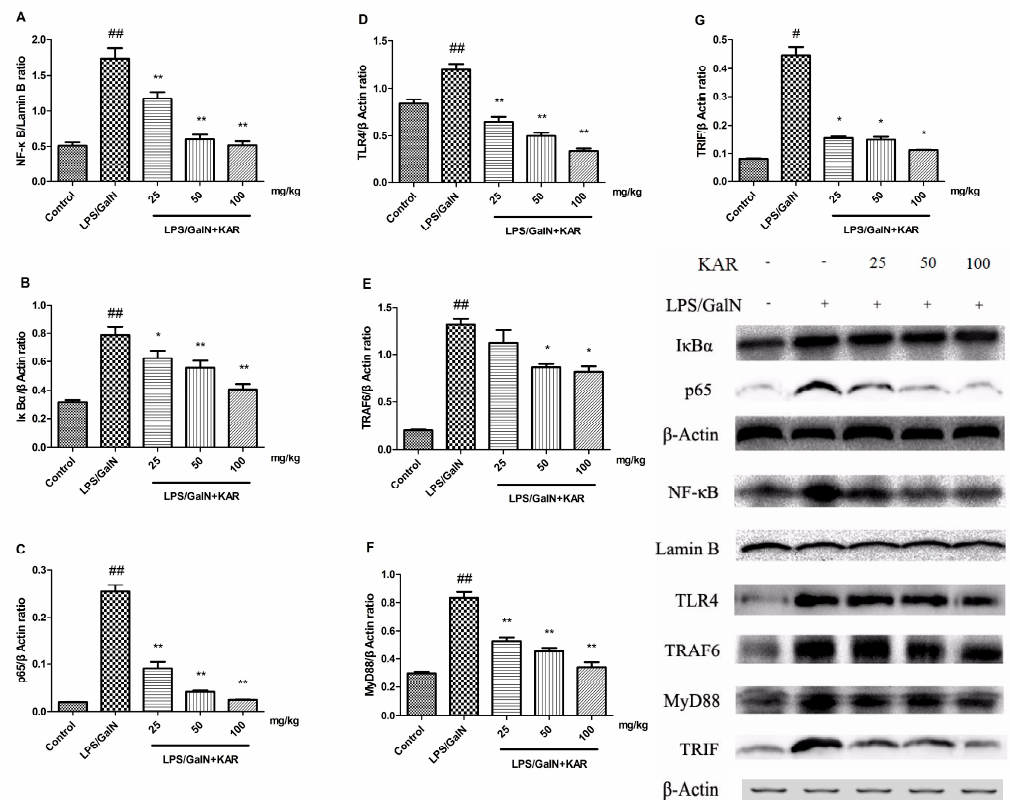
Figure 7. The expression of NF- κ B and TLR4 signaling pathway-related proteins, such as NF- Κ b ( A ); I κ B α ( B ); p65 ( C ); TLR4 ( D ); TRAF6 ( E ); MyD88 ( F ); and TRIF ( G ); were detected using a Western blotting assay in the liver tissues of each group 6 h after D-GalN/LPS administration. The data represented show the mean ± SD. Data of I κ B α , p65, and NF- κ B are normalized to that of Lamin B, and that of TLR4, TRAF6, MyD88, and TRIF are normalized to β -actin. * p < 0.05, ** p < 0.01 compared to the FHF model group, and # p < 0.05, ## p < 0.01 compared to the control group.